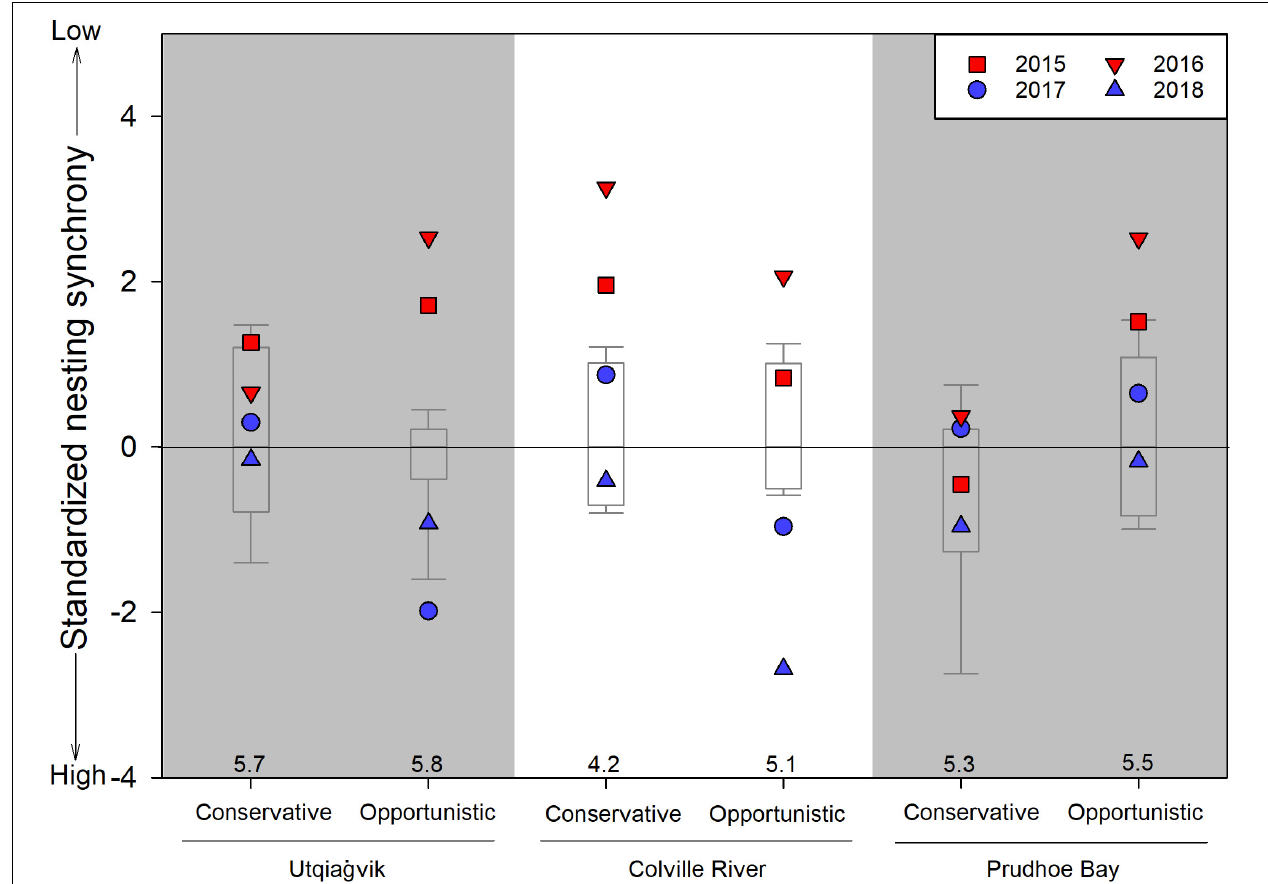
FIGURE 5 | Standardized shorebird nest synchrony (standard deviation of nest initiation dates, after Nol et al., 1997) by opportunistic and conservative reproductive strategies in 2015–2018 in relation to long-term values (i.e., Utqia˙gvik: 2005–2014; Colville River: 2011–2014; Prudhoe Bay: 2005–2014). Data are standardized for each year and reproductive strategy separately by subtracting from them the long-term median value (median values listed above x-axis); box plots represent the 25 th and 75 th percentiles with error bars at the 10 th and 90 th percentiles and the line crossing at the median value. Early springs (i.e., 2015 and 2016) are illustrated in red while late springs (i.e., 2017 and 2018) are illustrated in blue. Smaller values indicate greater nest synchrony. See Table 2 for species assignments to reproductive strategies and sample